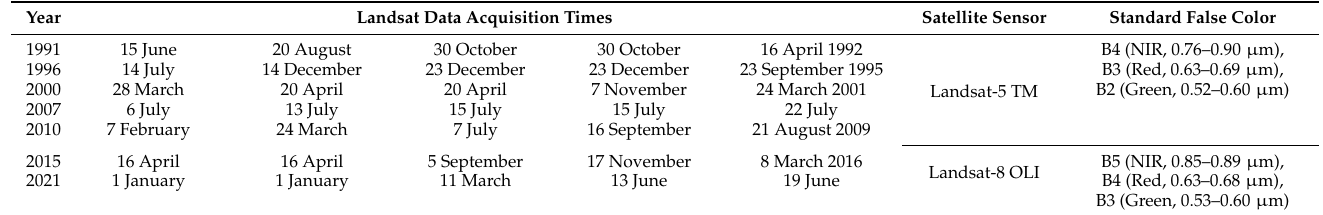
Table 1. Information about the Landsat data images used in the